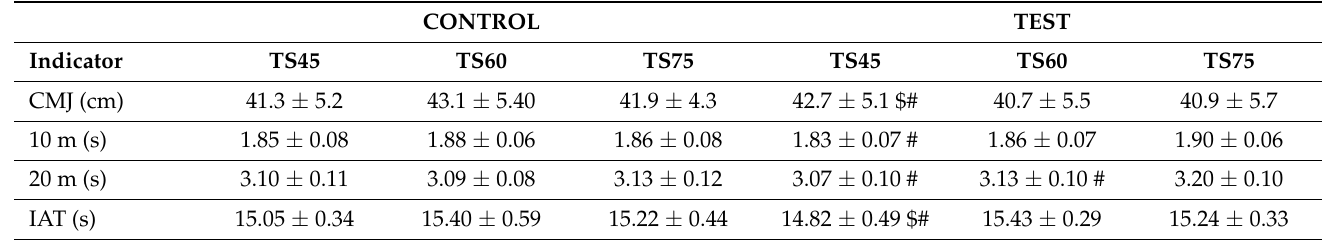
Table 2. Values of physical tests for CONTROL and TEST during the three weeks.